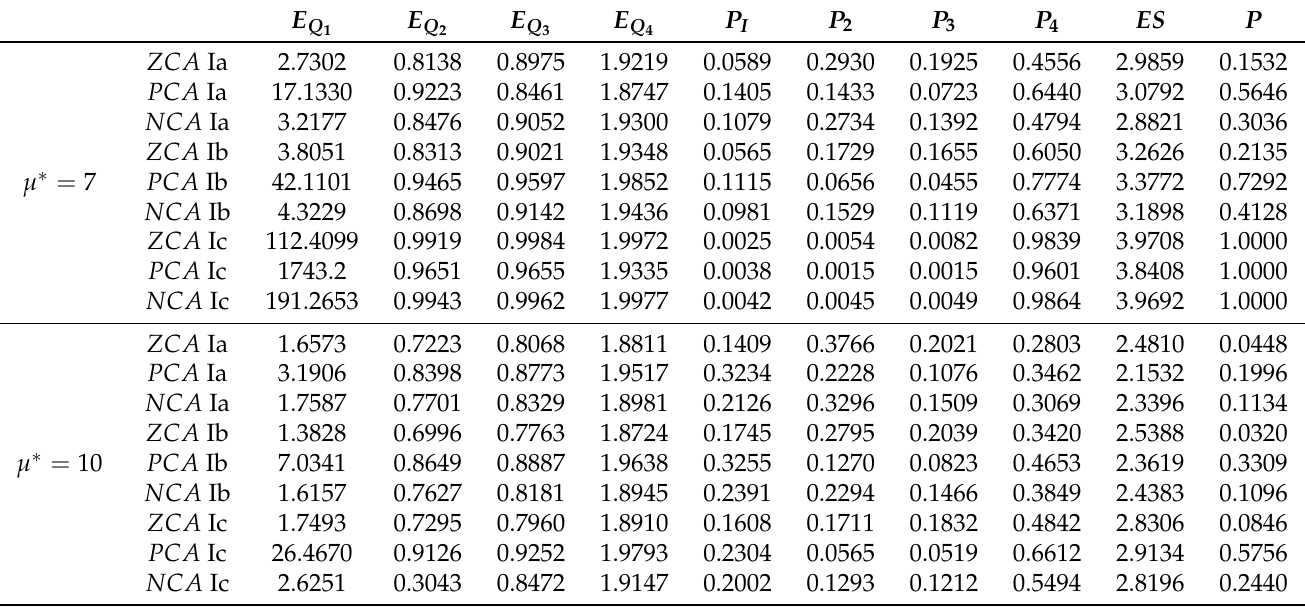
Table 11. Measures for various combination of arrival and service processes-Scenario I.